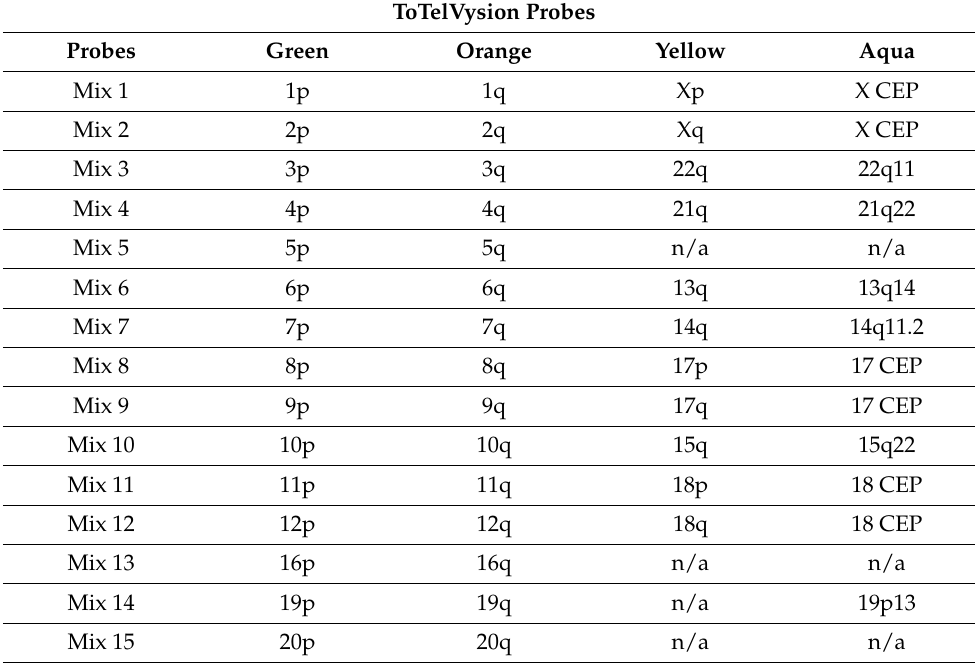
Table 1. A summary of probe loci and their respective fluorochrome colors for each of the 15 mixtures included in the ToTelVysion kit. CEP, centromere; p, short arm; and q, long